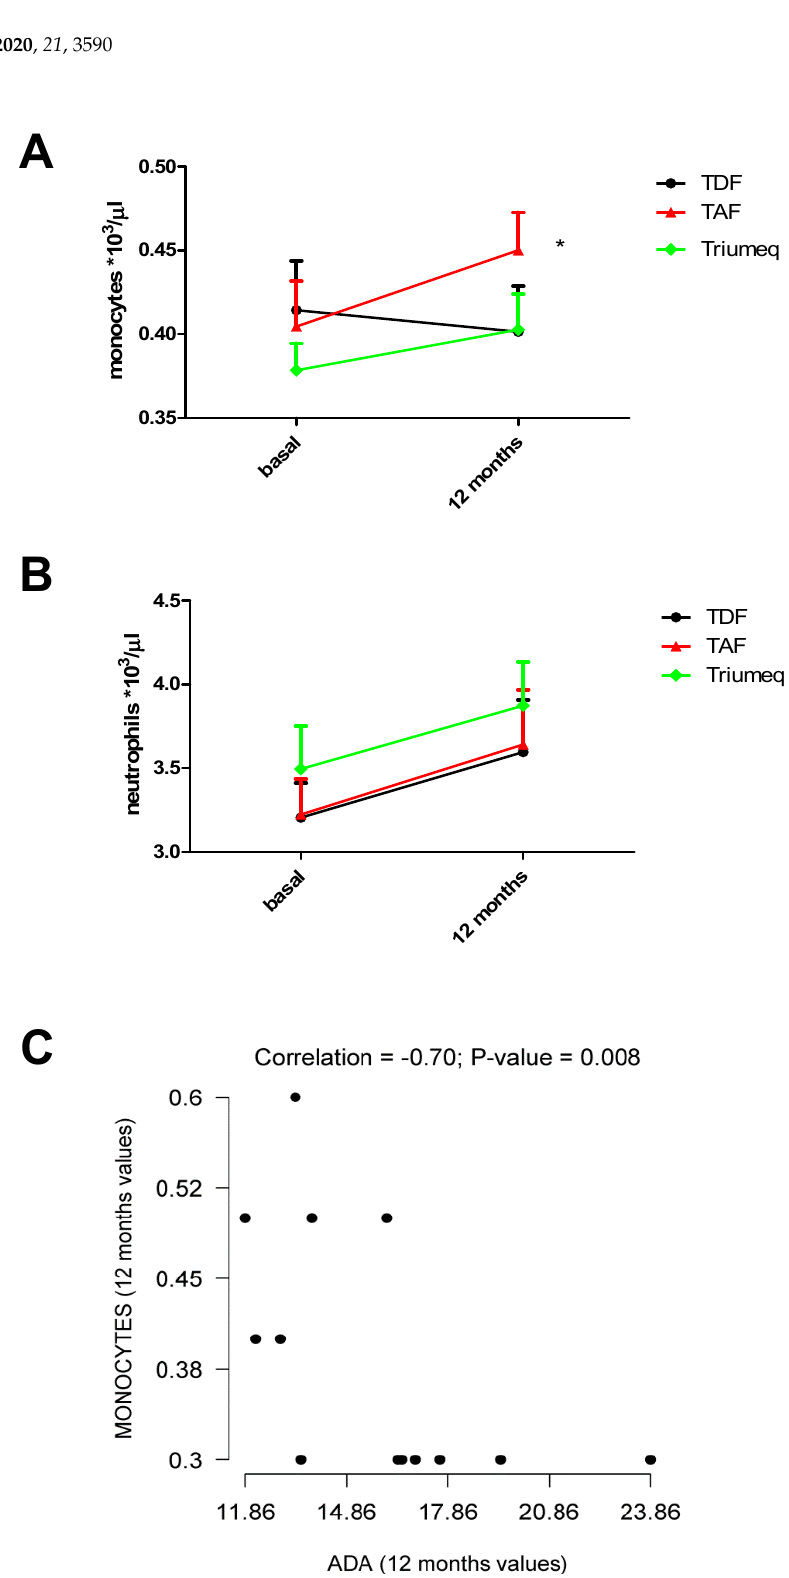
Figure 3. Monocyte and neutrophil counts at baseline and 12 months after antiretroviral treatment. ( A ) Changes in the number of monocytes for TDF, TAF, and Triumeq. ( B ) Changes in the number of neutrophils for TDF, TAF, and Triumeq. ( C ) Spearman correlation between ADA values and number of monocytes 12 months after treatment initiation * p < 0.05, t -student.